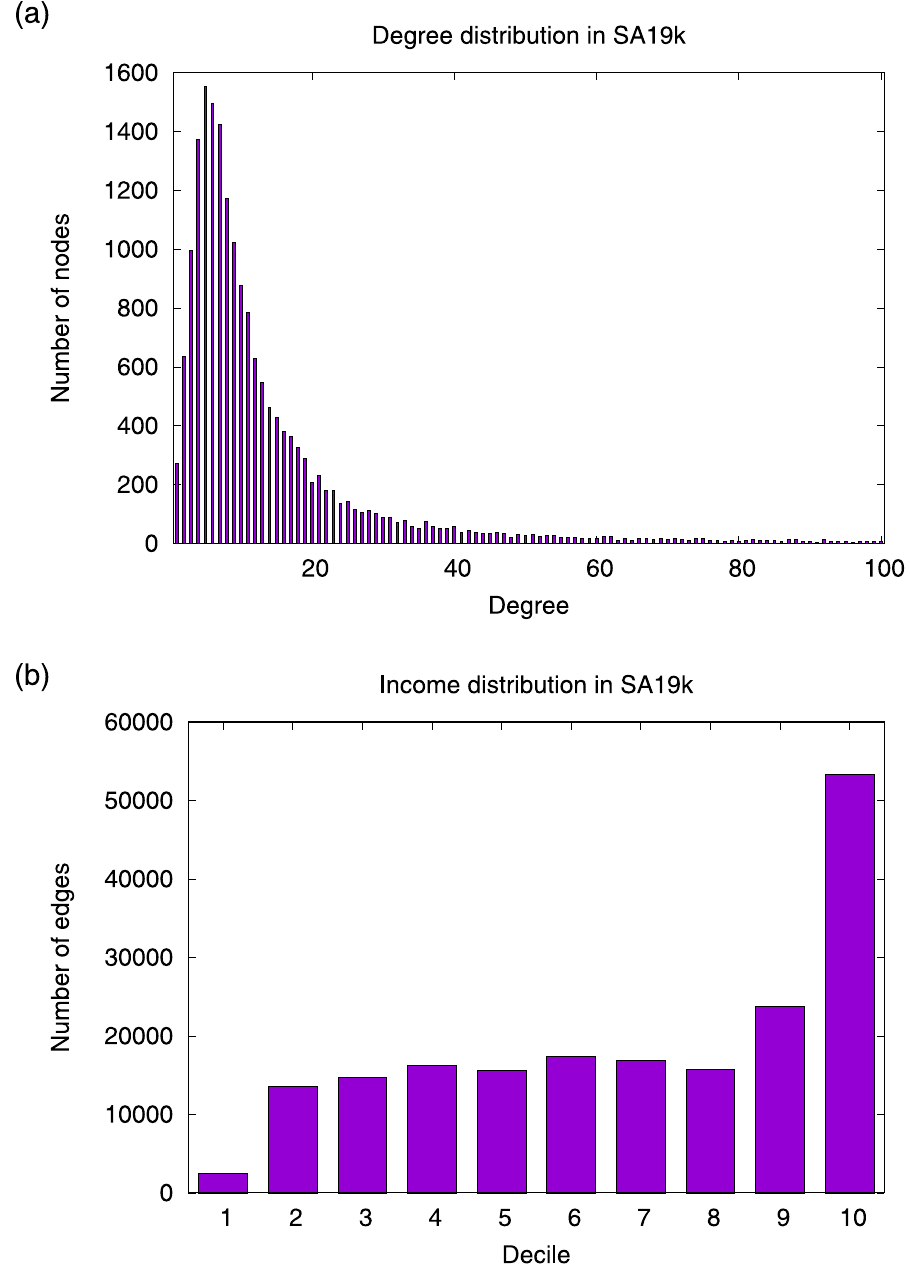
Fig 1. Node degree and income decile distribution in SA19k. a) Even though many nodes have around 5–7 neighbors, the degree distribution shows the presence of hubs; b) Most of the affinity relationships occur in the highest income decile, totaling the 29% of the edges of SA19k. On the other hand, affinities in the lowest decile are almost unexistent. The other income deciles are quite similar, with around 8% of the edges per decile.